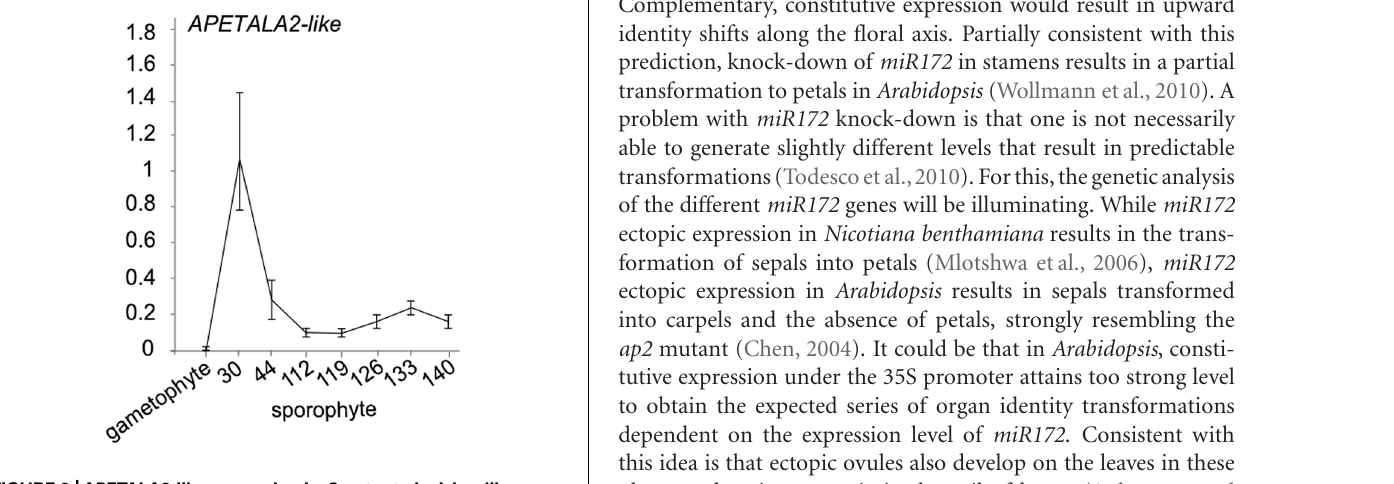
FIGURE 3 |APETALA2-like expression in Ceratopteris richardii developmental time series. qRT-PCR of a putative miR172 target APETALA2-like gene with a putative miR172 binding site in gametophytes and sporophyte stages of development. Error bars are standard deviation of three biological